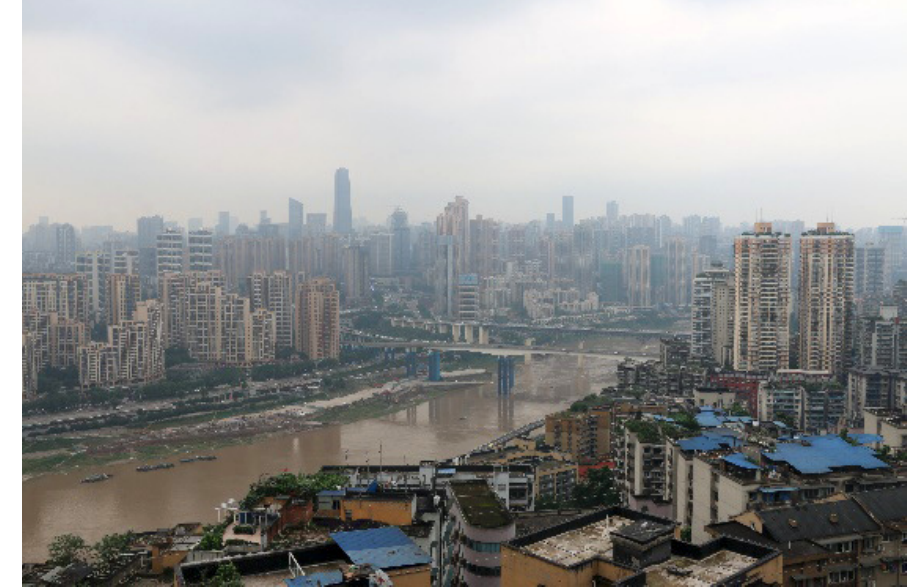
Figure 2. Part of Chongqing’s skyline, with many high‐rise buildings and bridges across the river. the building and has even become a tourist attraction (see Figure 3).